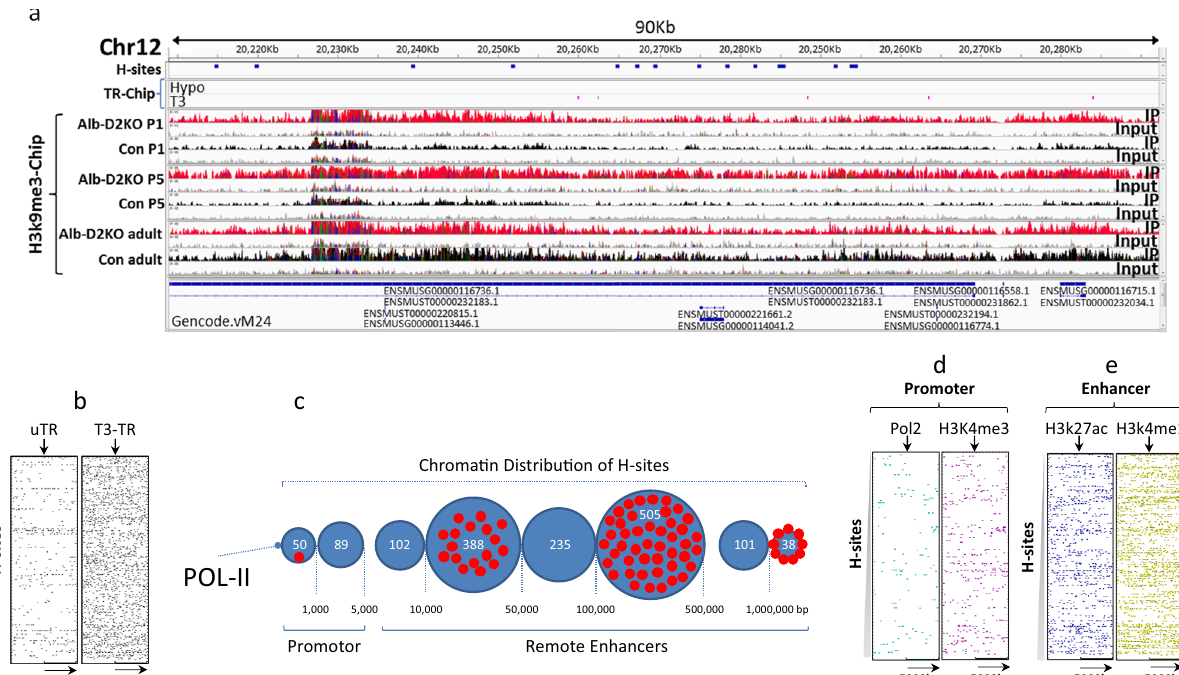
Fig. 1 DNA hypermethylation sites (H-sites) in the ALB-D2KO mouse liver chromatin. a browser IGV image of the indicated portion of the mouse chromosome 12 containing 15 H-sites; the following tracks contain ChIP signals for: (top to bottom) H-sites (blue), TR ChIP-seq peaks (hypo and T3- treated - pink), H3K9me3 ChIP-seq peaks in Alb-D2KO (red) and control (black) P1, P5 and adult mice; the input track is shown in gray; a close-up picture of a single H-site is shown in Supplementary Fig. 1B; during optimization of the experimental conditions the pull down was repeated 8 times with different samples; hence replication of experiment (repeating the whole experiment) was not performed as the fi gure shows data from 12 P1 mice and 6 P5 mice; for adult animals, the fi gure shows data from 6 mice. b heat-maps of H-sites vs. TR ChIP-seq peaks in liver; the x -axis contains the TR peak coordinates at the center + / – 5 Kbp and the y -axis contains the H-site coordinates; the H-site coordinates start at the top and progresses downwards in the following order: Chr 1 through Chr 9, Chr X, Chr 10 through Chr 19; each dot in the heat-map indicates an H-site and its relative distance to a TR peak (center); Hypo indicates TR ChIP peak coordinates obtained from hypothyroid mice, and + T3 indicates TR coordinates obtained from T3-treated mice; c distribution of H- sites as a function of polymerase II (pol-II) ChIP-seq peak locations; the numbers at the bottom indicate the distance in base pairs (bp); H-sites are within the promoter if up to 1 Kbp; the H-sites are grouped in blue circles according to the distance bracket; the numbers of H-sites in each bracket is indicated inside the blue circles, in white; red dots are H-sites imbedded in areas enriched with H3K9me3 during P1-P5; d same as in b , except that Pol-II and H3K4me3 (core promoter makers) ChIP-seq peaks were placed at the center of each respective heat-map; e same as in b , except that H3K27ac and H3K4me1 (enhancer makers) ChIP-seq peaks were placed at the center of each respective